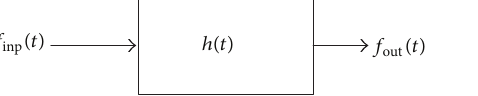
→ 𝑓 (𝑡) = ZSR (𝑡) ) given inp out